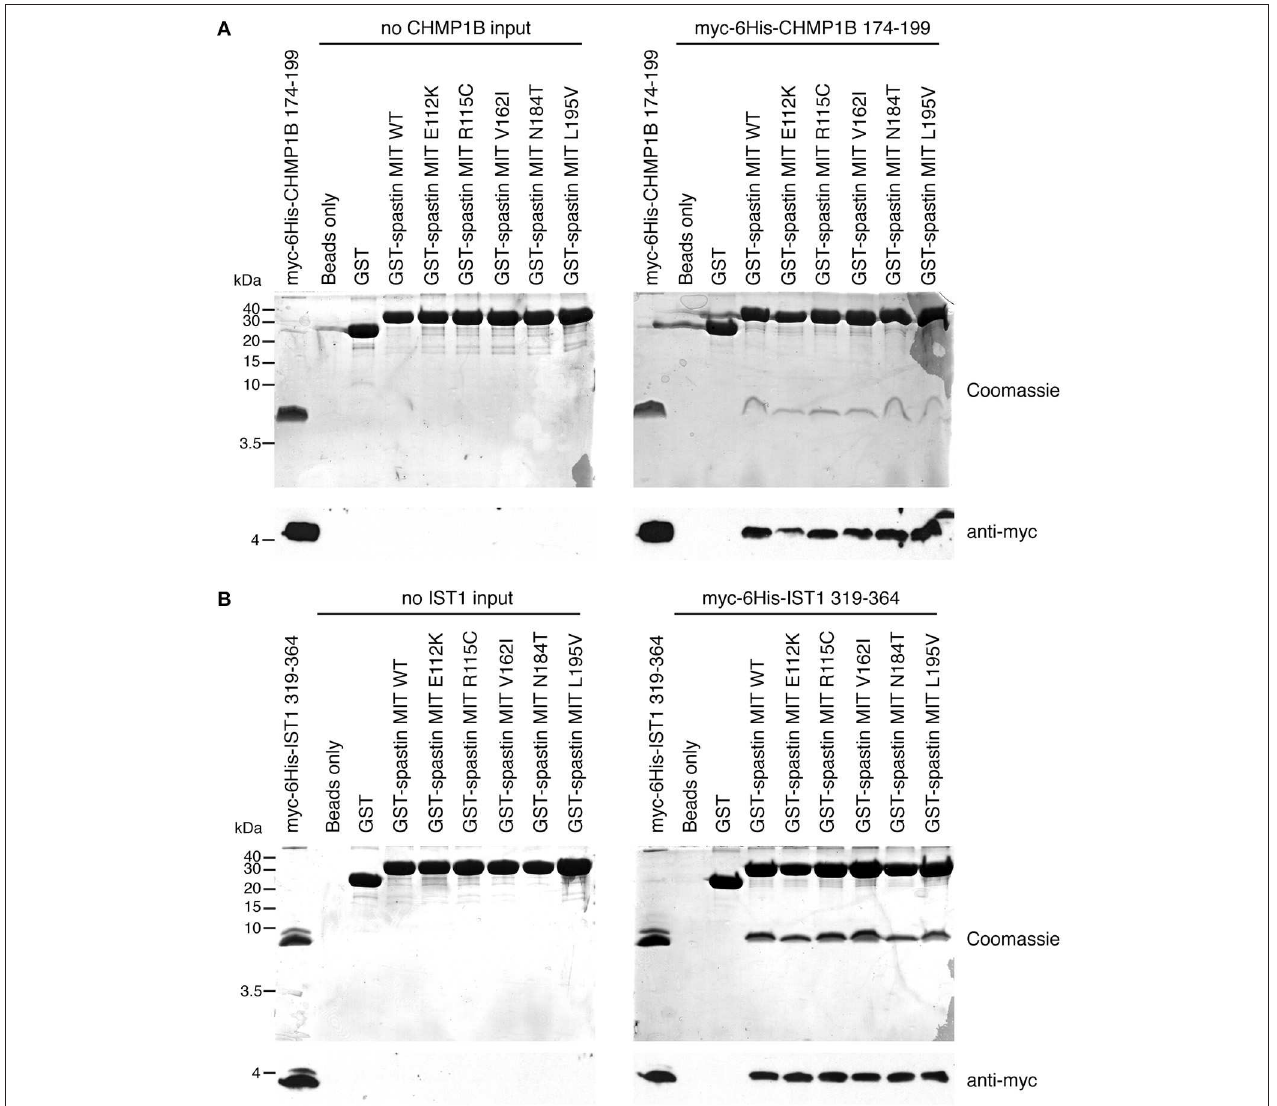
FIGURE 6 | Assessment of interactions between spastin MIT domains and MIM-regions of CHMP1B and IST1 by GST pull-down. Purified proteins consisting of GST alone, GST fused to the wild-type spastin MIT domain, or to spastin MIT domains harboring the sequence changes indicated were used in in vitro GST pull-down experiments vs. myc- and 6His-tagged fragments of CHMP1B (A) or IST1 (B) that incorporate the spastin-binding MIM regions. In each set of experiments, the upper panels show Coomassie-stained gels, while the bottom panel shows corresponding anti-myc